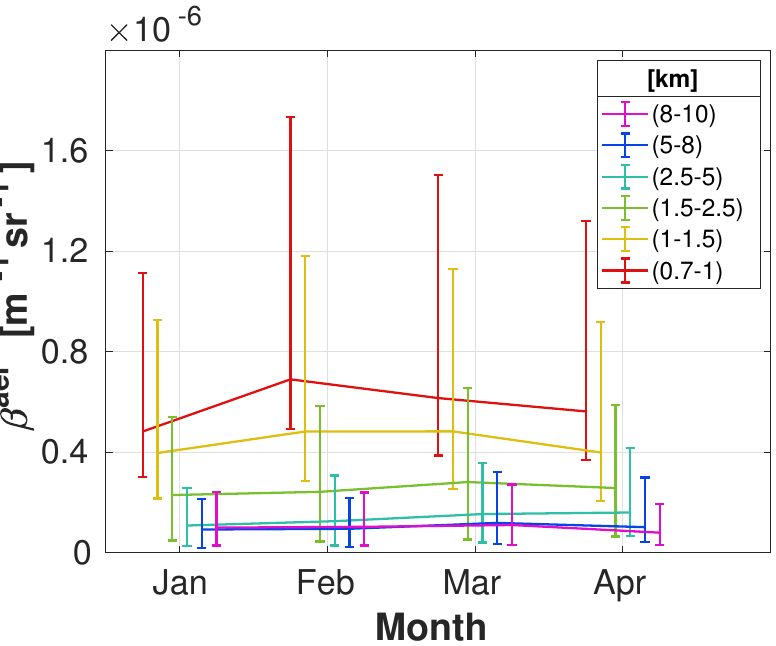
Figure 3. Backscatter coefficient β aer ( 532nm ) over time for different altitude ranges. The median value is plotted (different colors mark altitude ranges). The error bar is the mean value of all values larger and smaller than the median. Table 1. Median of the lidar ratio LR for different altitude ranges and months in 2020, with high and low backscatter events presented separately. The 25th and 75th percentiles are indicated in the